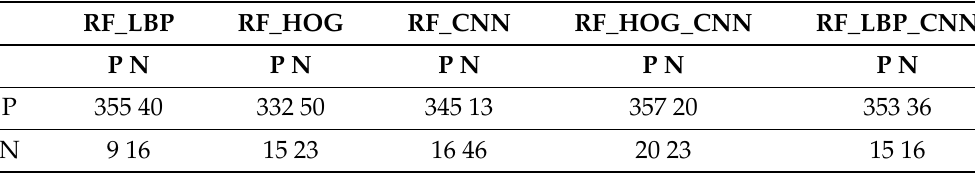
Table 6. Confusion Matrix for RF with other Feature Descriptors.